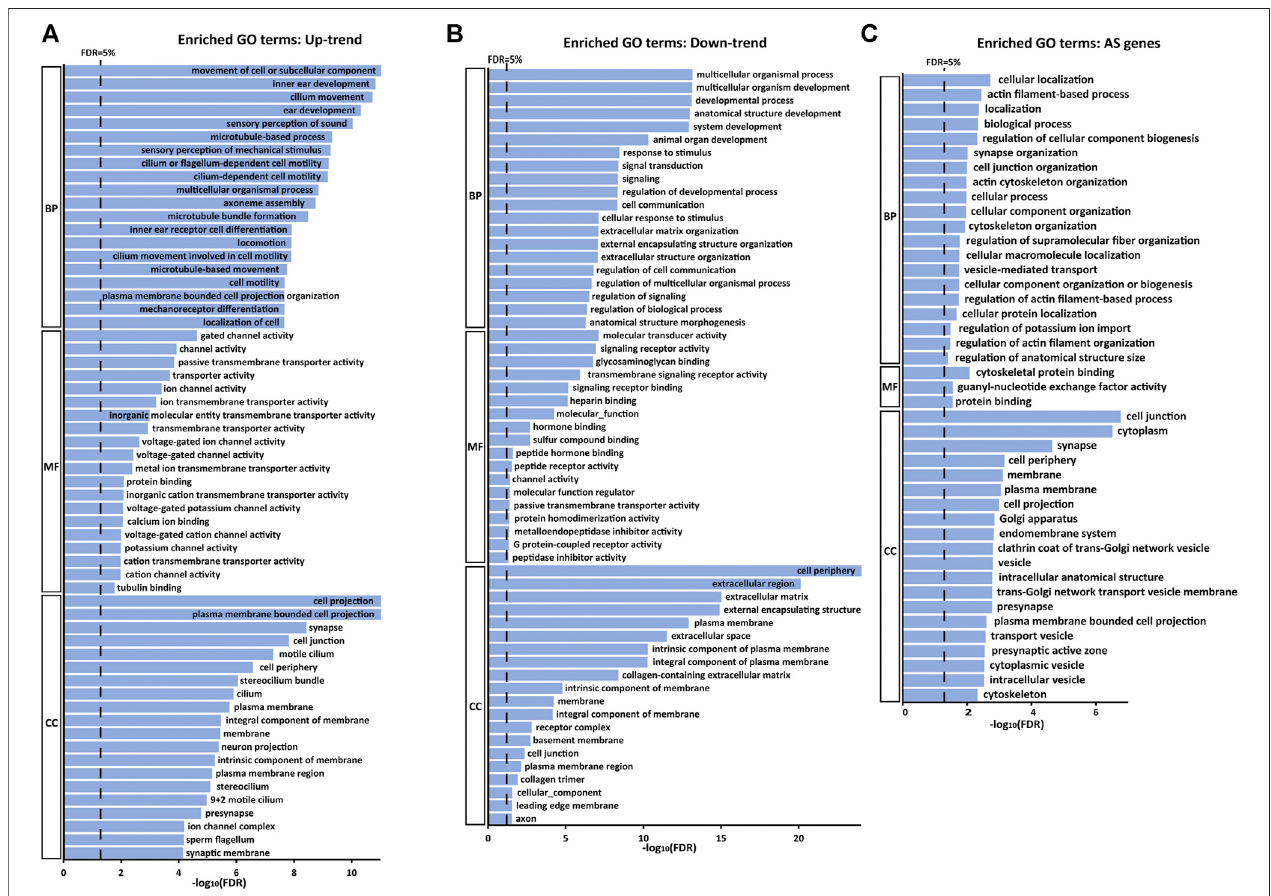
FIGURE 4 | GO enrichment analysis of Up-trend genes, Down-trend genes, and differential exon skipping events. Up to top 20 signi fi cant GO terms (FDR < 5%) in the GO biological processes (BP), molecular functions (MF) and cellular components (CC) categories are listed in the bar graph (A) Enriched GO terms with Up-trend genes. (B) Enriched GO terms with Down-trend genes. (C) Enriched GO terms with AS